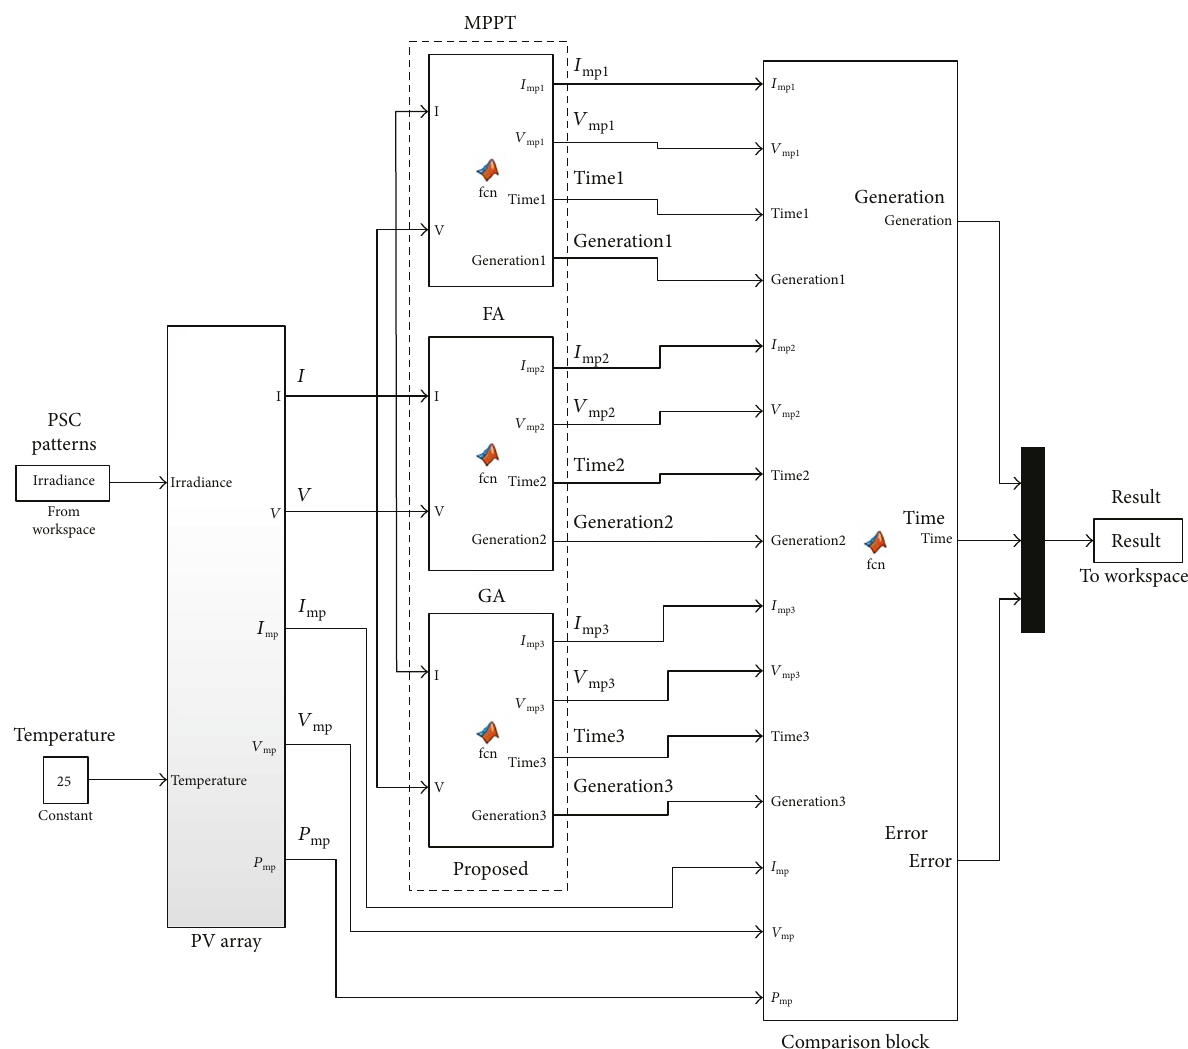
Figure 5: System blocks for evaluation. Table 1: Parameters of the experimental